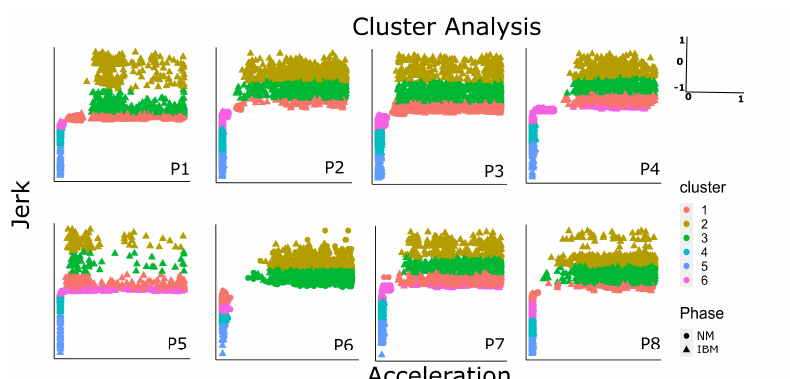
Figure 4. K means cluster analysis for all of the participants. Each panel shows the results of K means clustering for a single participant. The magnitudes for (cid:126) a on the x-axis and (cid:126) j on the y-axis were normalized between 0 and 1, and − 1 and 1, respectively. The NM and IBM phases are represented by circle and triangle shapes, respectively. Clusters 1 and 6 show overlap between NM and certain IBM sub-phases, whereas clusters 2, 3, 4, and 5 show more patterns revealing different sub-phases of IBM. For one participant, a few NM phase data points were clustered into cluster 2 due to the